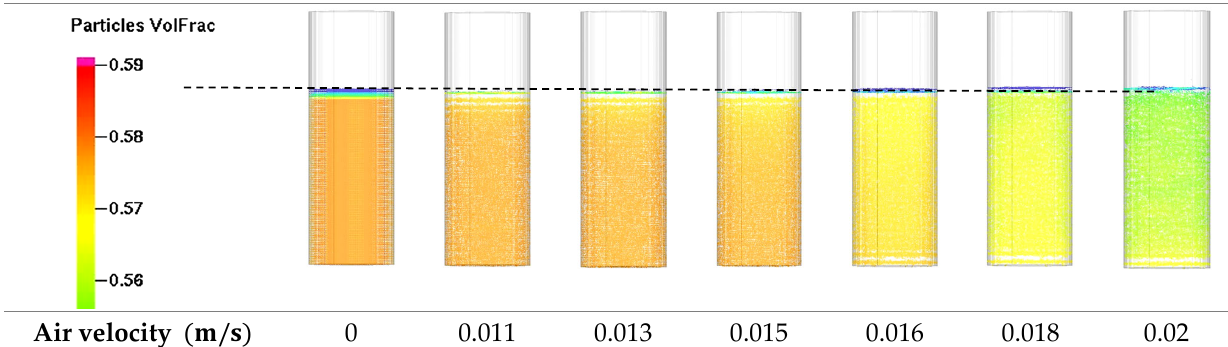
Figure 15. Snapshots from the simulations at different superficial air velocities.